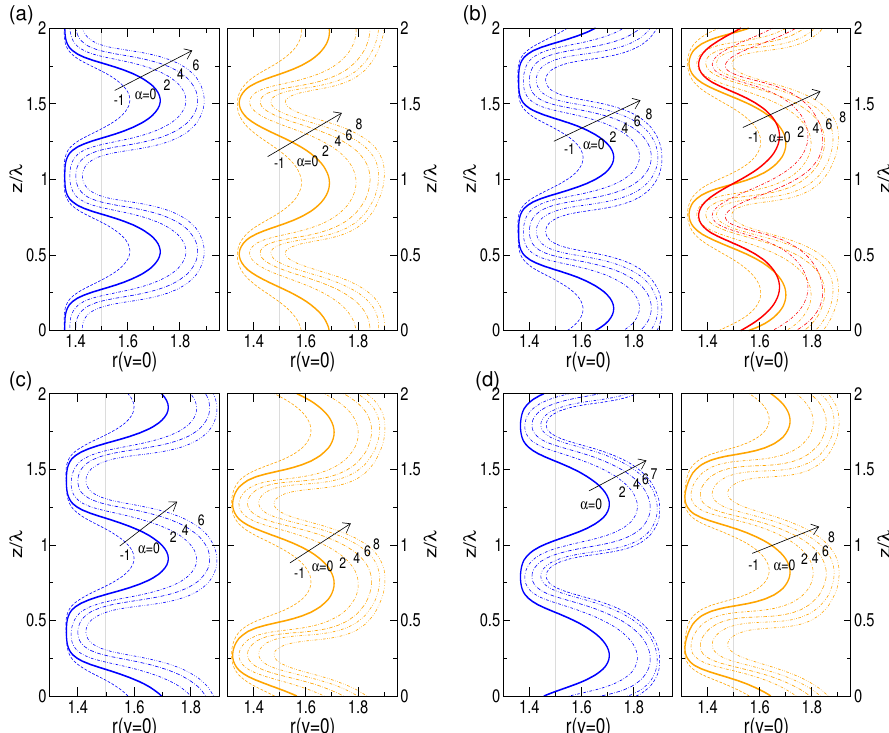
Figure 7. Degree of anharmonicity δ = ( a ) Re = 0, ( b ) Re = 5, ( c ) Re = 10, and ( d ) Re = 20.